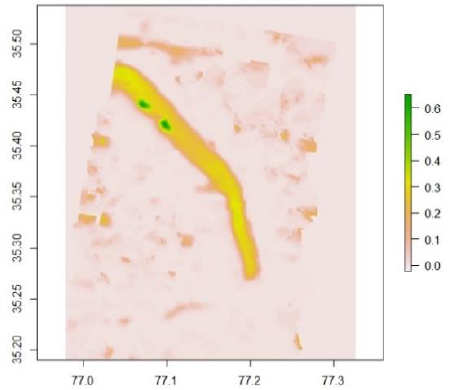
Figure 4: Siachen glacier velocity map using descending pass TerraSAR-X images. (22 Aug. 2013 and 03 Feb. 2014) (Figure scale in m day -1 ).